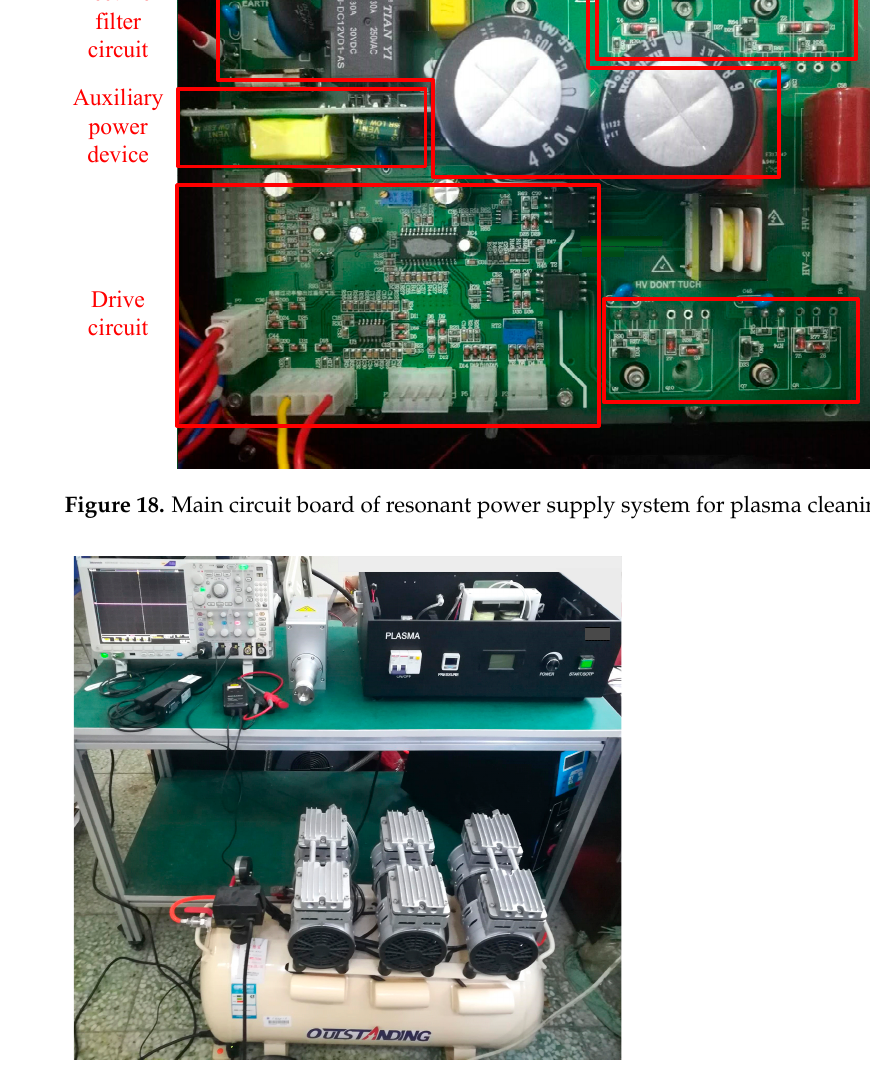
Figure 19. Experimental platform of resonant power supply system for plasma cleaning.